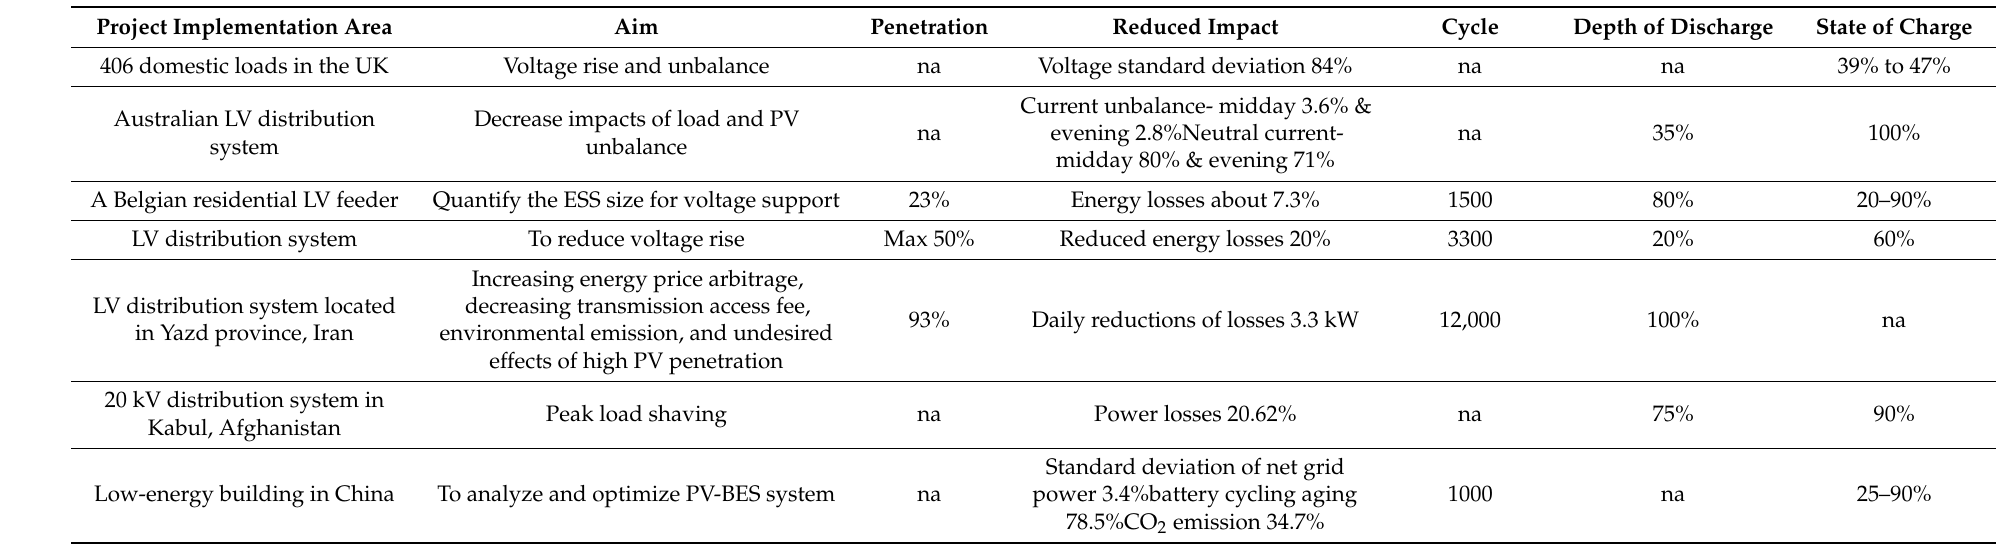
Table 4. Summary of different ESS